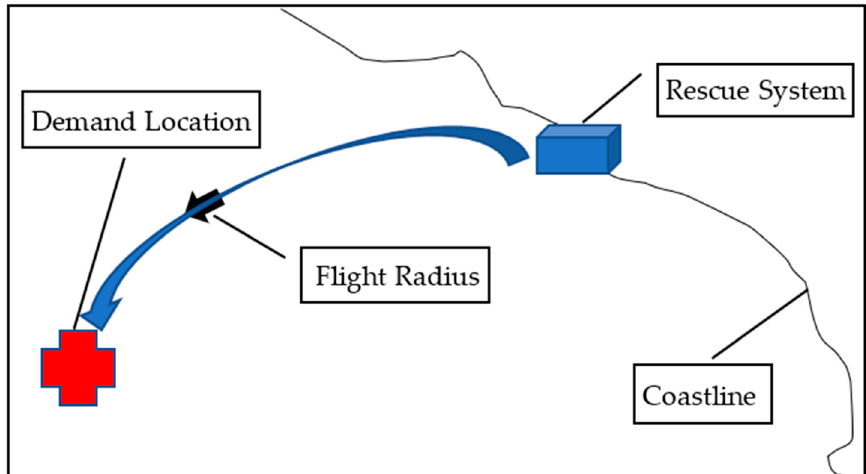
Figure 6. Overrun UAV radius diagram.